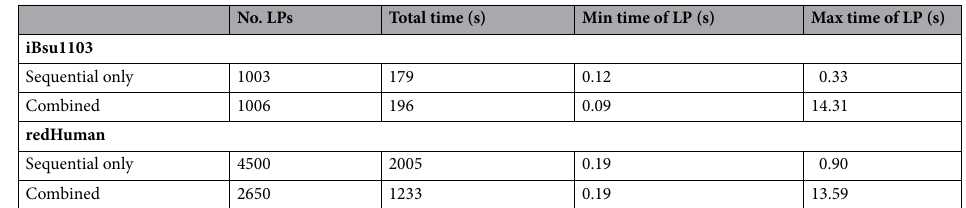
Table 1. Comparison of the combined and sequential implementation. The comparison is carried out on two genome-scale models, iBsu1103 and redHuman. Shown are the number of linear programs (LPs), total time for the execution of the procedure, and the minimum and the maximum time (in seconds) needed to solve a single linear program within the entire procedure.